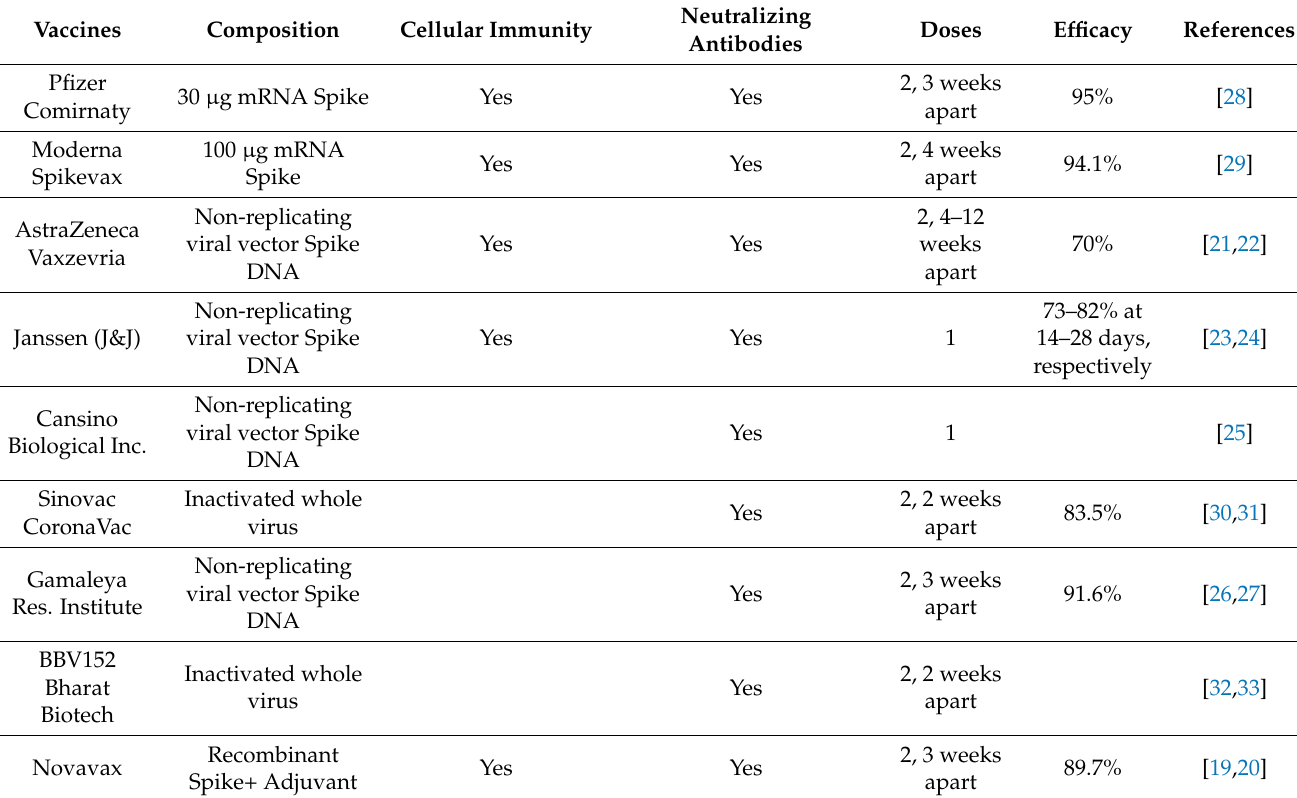
Table 4. Characteristics of anti-COVID-19 vaccines available or in advanced phase of